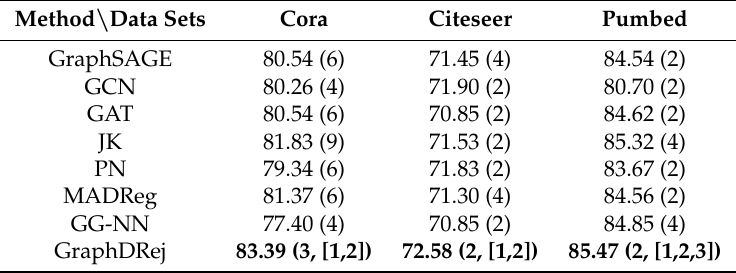
Table 3. The best performance for GNNs on the node classification task. For baselines, the number in parentheses next to the accuracy indicates the best performing number of layers. For GraphDRej, the first number in parentheses has the same meaning as that in baselines, and the second list in parentheses refers to the value set of γ adopted by the corresponding